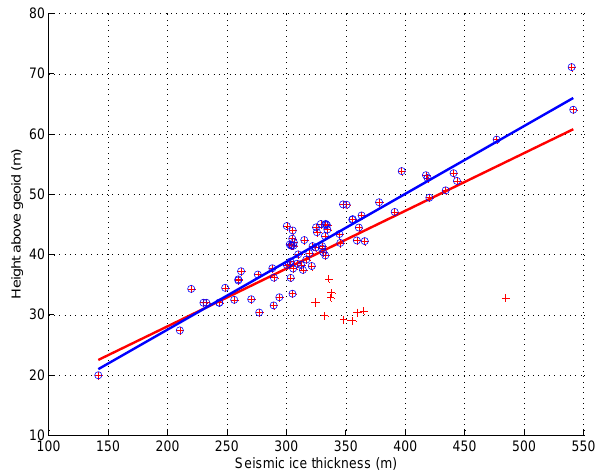
Fig. 5. Geoid-corrected height (h) against seismic ice thickness (H). Red crosses represent all sites. Blue circles highlight those sites deemed unaffected by the proximity of the grounding line, i.e., fully floating excludes sites with negative firn correction calculated from elevation and seismic thickness as per Griggs and Bamber (2009). The red line is the linear fit to all data; the blue line is the linear fit to fully-floating sites (Fit: h = (0.113 ± 0.005) H + (5.003 ± 1.525); R 2 = 0 . 89). No correction for tidal variation in surface elevations was made and this therefore contributes to the scatter observed in the data ( ± 2m at the Churchill Camp, Fig.